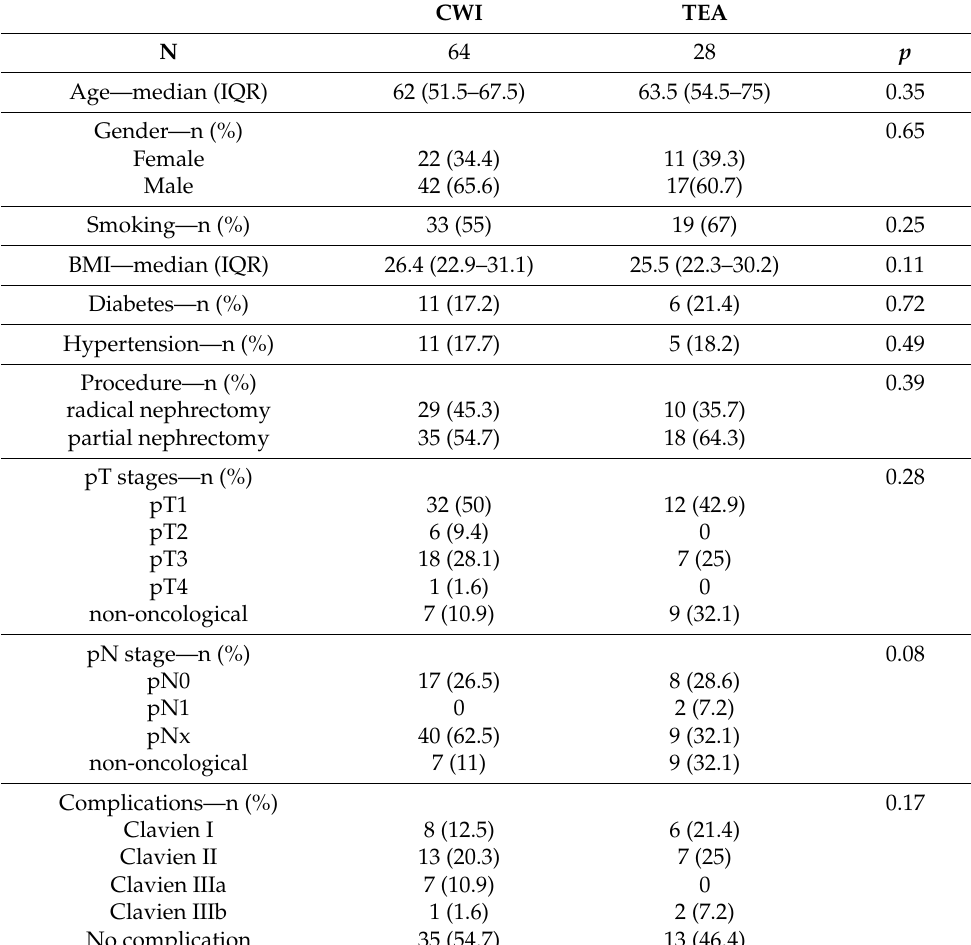
Table 1. Patients’ characteristics of the two studied populations either with continuous wound infiltration (CWI) or with thoracic epidural analgesia (TEA).